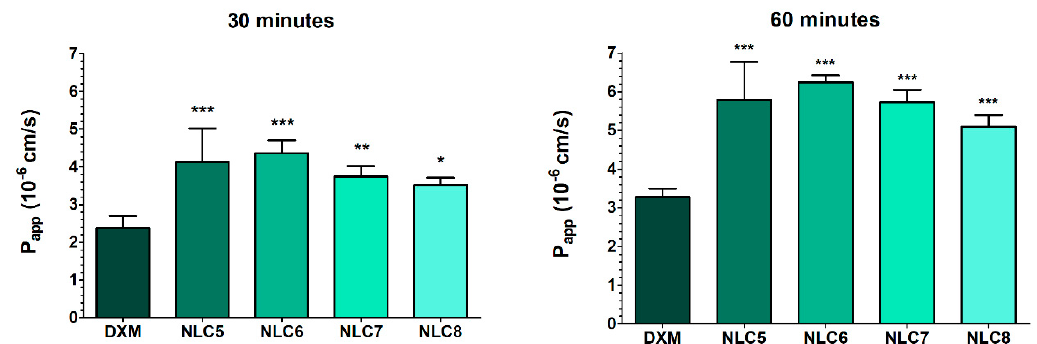
Figure 10. Apparent permeability coefficients (P app ) for DXM suspension (DXM) or in different formulations (10-times dilution of NLCs) measured across HCE-T corneal epithelial cell layers after 30 and 60 min of incubation. Values are presented as means ± SD, n = 4/group. Statistical analysis: ANOVA followed by Dunnett’s test. (* p ≤ 0.05 significant; ** p ≤ 0.01 very significant; and *** p ≤ 0.001 highly significant difference from DXM suspension (DXM susp.)).